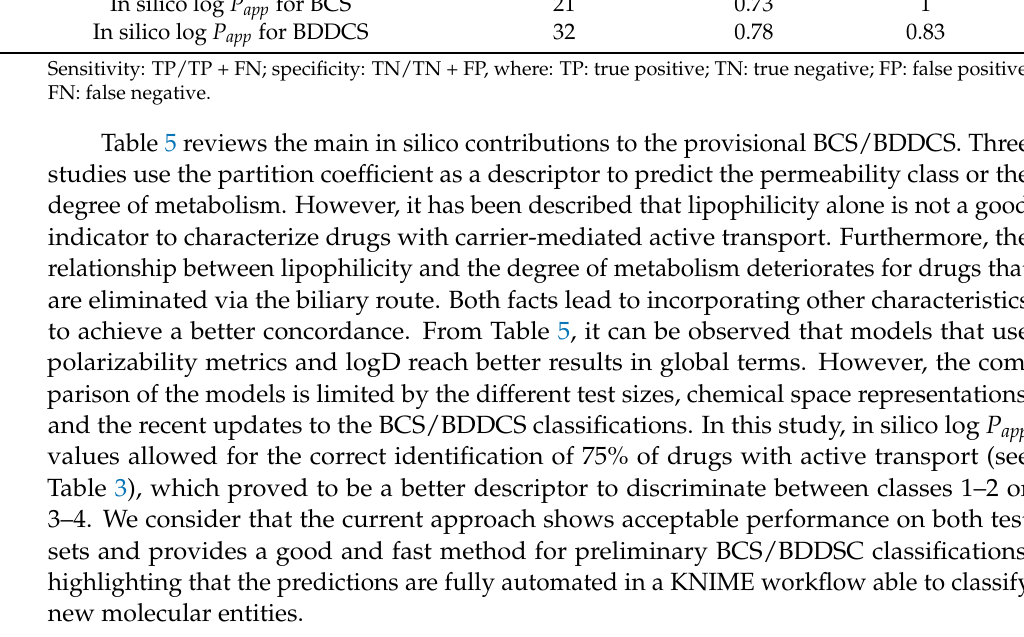
Table 5. Comparison of methods, variables, and model performance with previous in silico